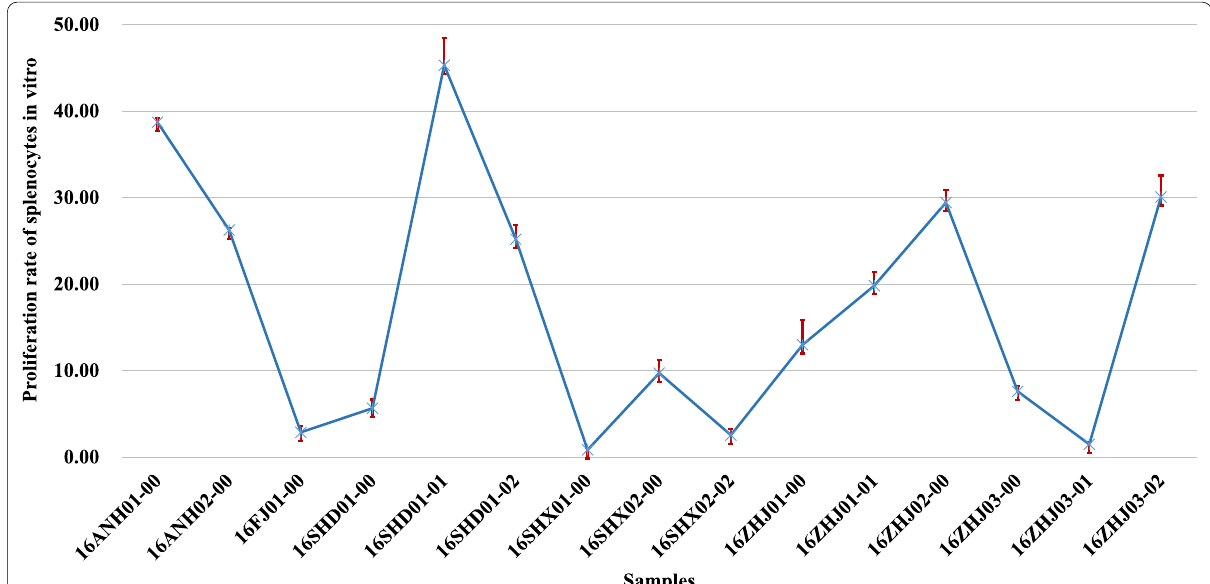
Fig. 8 Proliferation rate of splenocytes in vitro treated with polysaccharides extracted from fruit bodies of 15 lingzhi